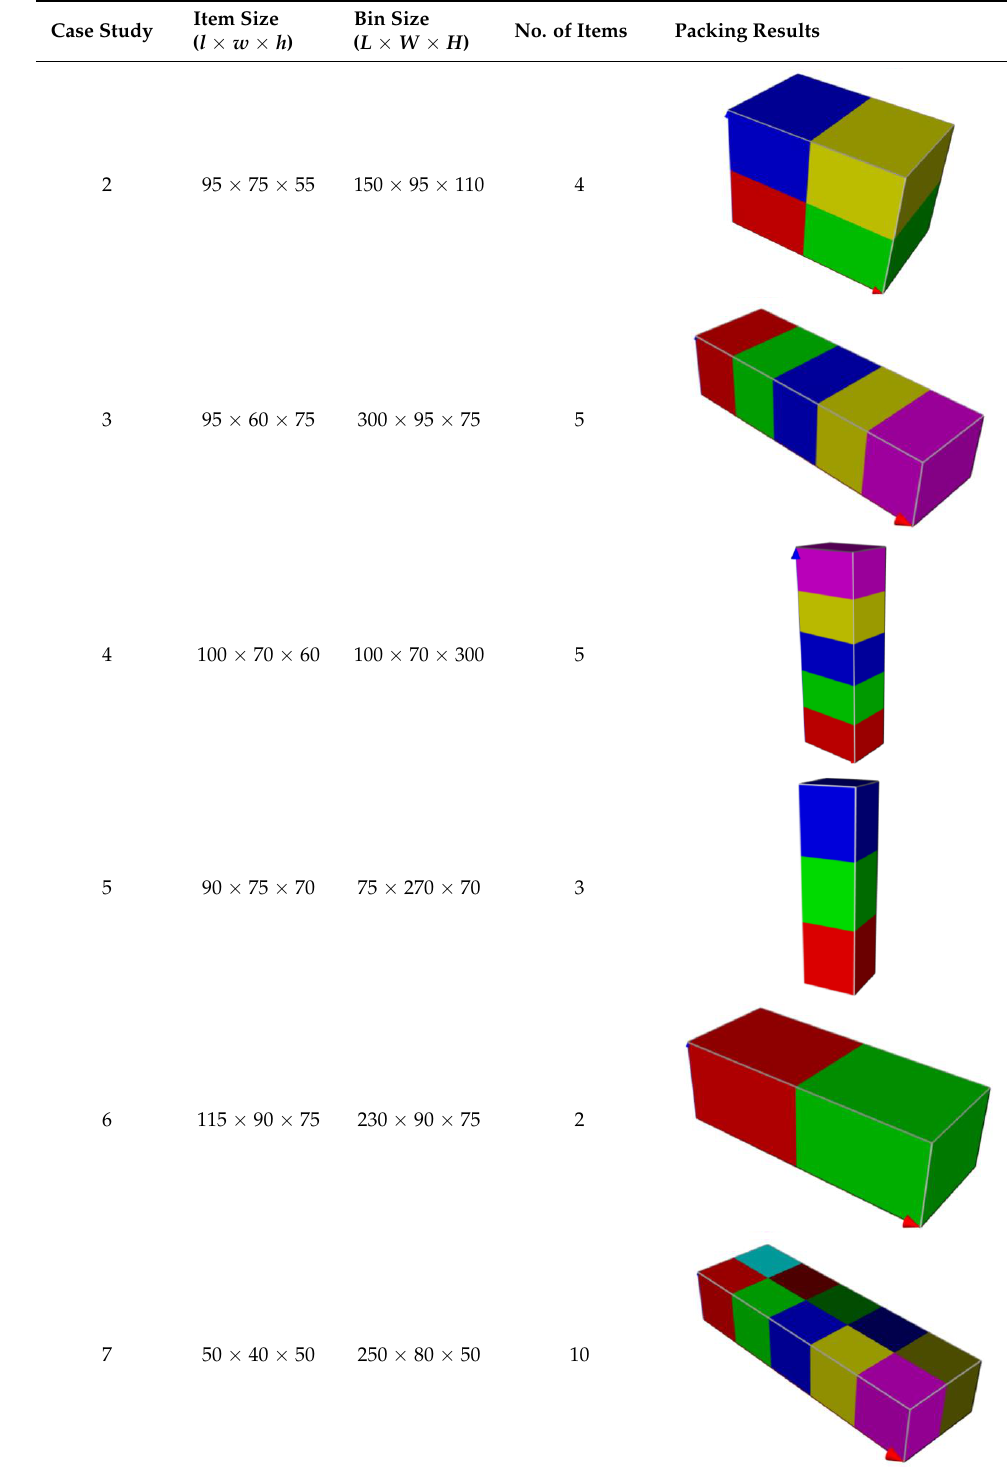
Table 9. The packing results for different bin sizes.